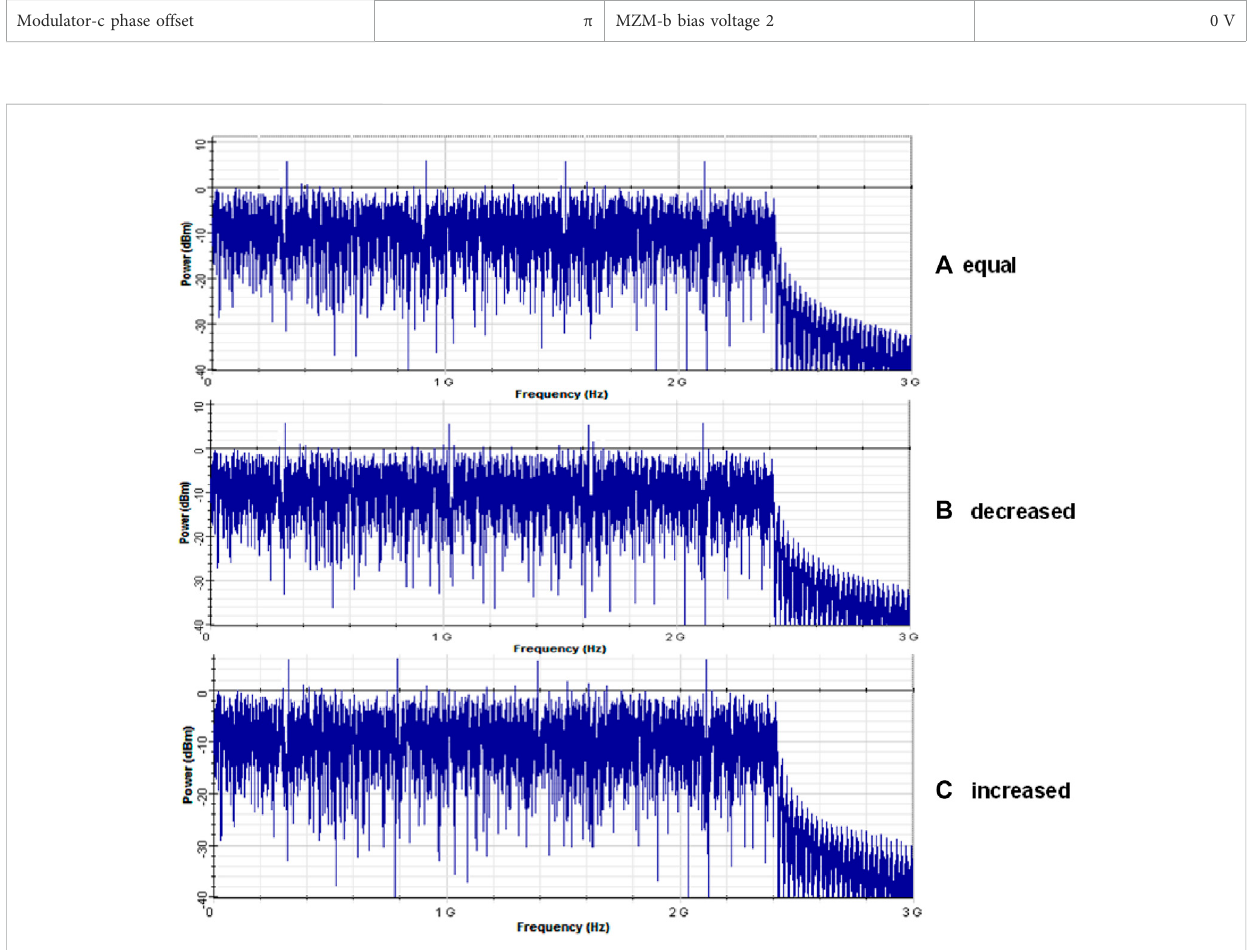
FIGURE 5 OFDM spectrum of different pilot interval schemes in the transmitter. (A) The equal-interval scheme; (B) The decreased-interval scheme; (C) The increased-interval